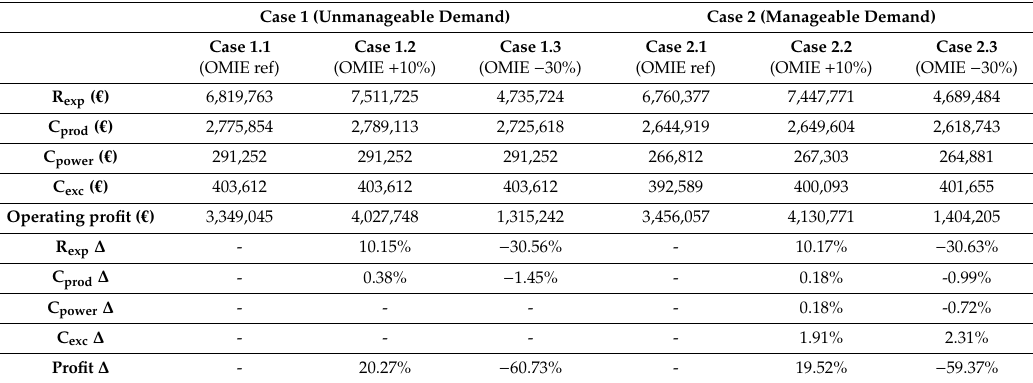
Table 11. Annual results, income and costs of all case